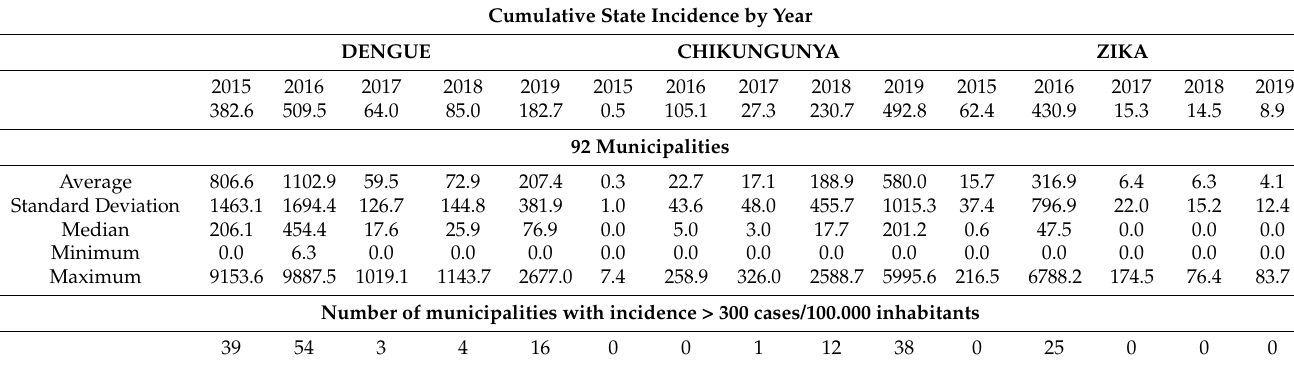
Table 1. Dengue, chikungunya, and Zika by year of symptom onset, Rio de Janeiro state,